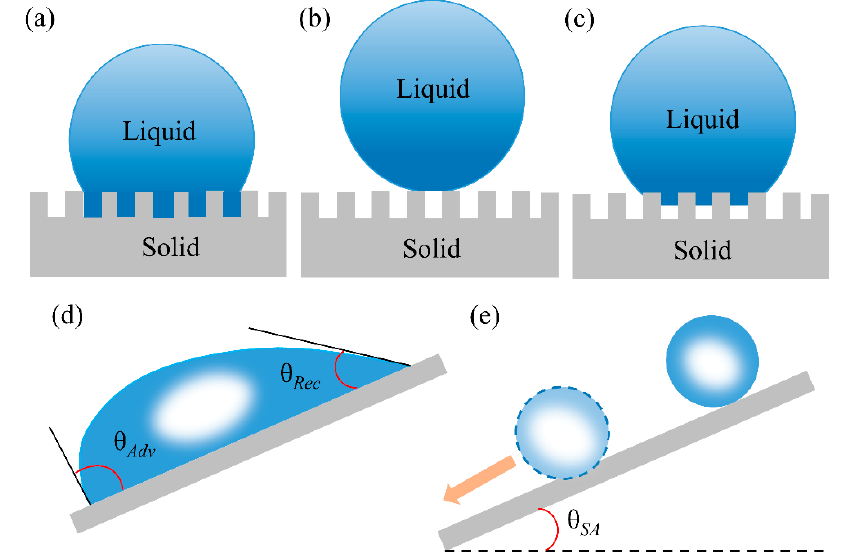
Figure 5. Effect of solid surface structure on wetting behavior: ( a ) Wenzel mode [70], ( b ) Cassie–Baxter mode [76], ( c ) intermediate states between the Wenzel and the Cassie modes [33]; reproduced with permission from Wiley. ( d ) Illustration of the “tilted plate” method to measure advancing/receding angle, respectively when the drop just starts to move [73]; reproduced with permission from Springer. ( e ) Illustration of the sliding angle [83]; reproduced with permission from the Royal Society of Chemistry.